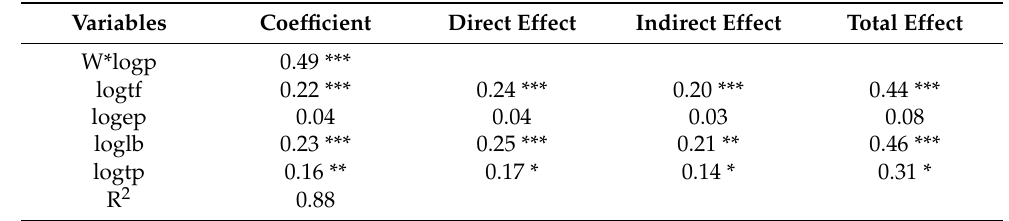
Table 8. Results of the SLM with spatial fixed effects for the middle region in China.